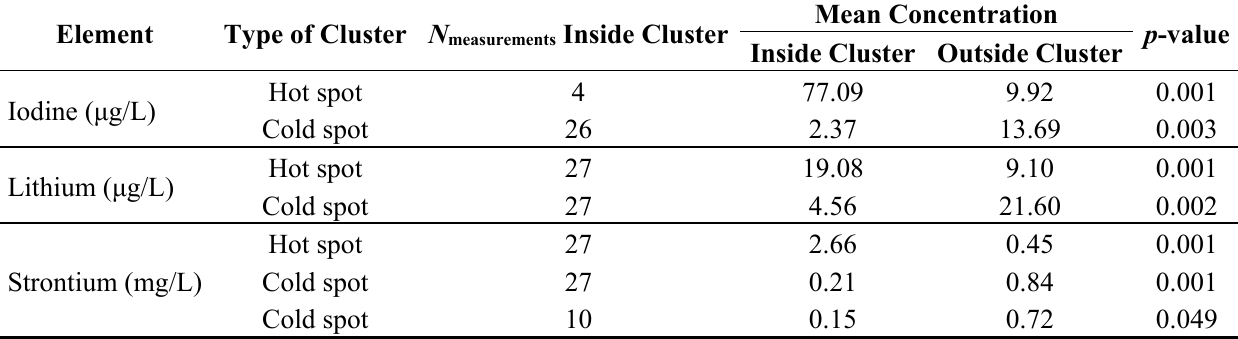
Table 2. Geographical clusters of high (hot spot) and low concentrations (cold spot) of iodine, lithium, and strontium in drinking water. Element Type of Cluster N measurements Inside Cluster